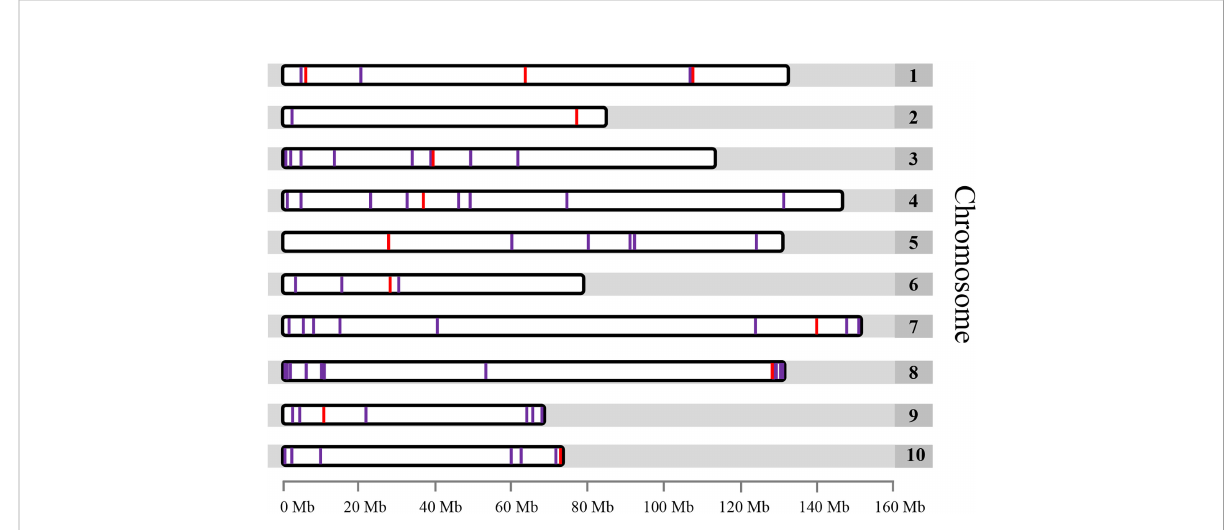
FIGURE 1 Distribution of the 71 identi fi ed single copy genes free of repetitive sequence within the garden asparagus genome represented by 10 chromosomes. Only single copy genes located on chromosomes are shown. The red lines denote the single copy genes that were used for